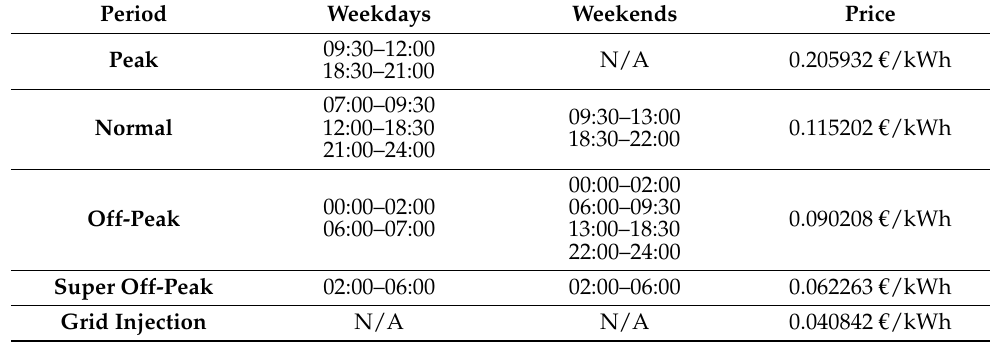
Table A1. Weekly tariff cycle for the DEEC